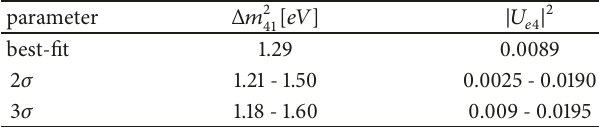
Table 3: Best-fit, 2 𝜎 and 3 𝜎 values (from [15])of the oscillation parameters with three standard neutrinos’ and one sterile neutrino’s states